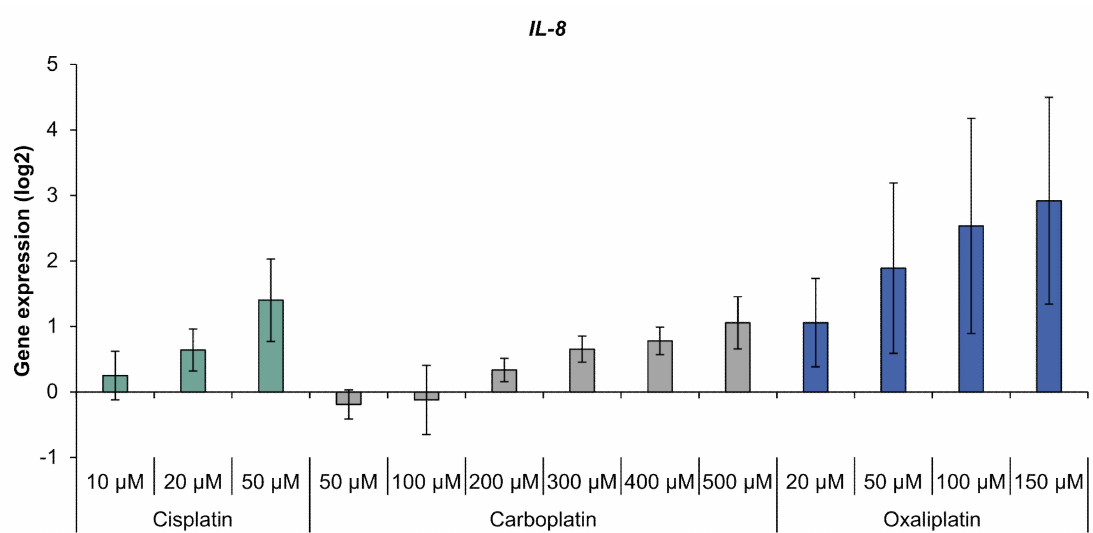
Figure 4. Gene expression of IL-8 in A498 cells after incubation with cisplatin, carboplatin or oxaliplatin. Cells were treated for 1 h with cisplatin (10, 20, 50 µ M), carboplatin (50, 100, 200, 300, 400, 500 µ M) or oxaliplatin (20, 50, 100, 150 µ M), followed by a postcultivation of 24 h. Afterwards, gene expression was analyzed using high-throughput RT qPCR. The log2 mean values are shown of three independent experiments normalized to the untreated control whereby the control equals 0 ± standard deviation. The data for cisplatin are taken from